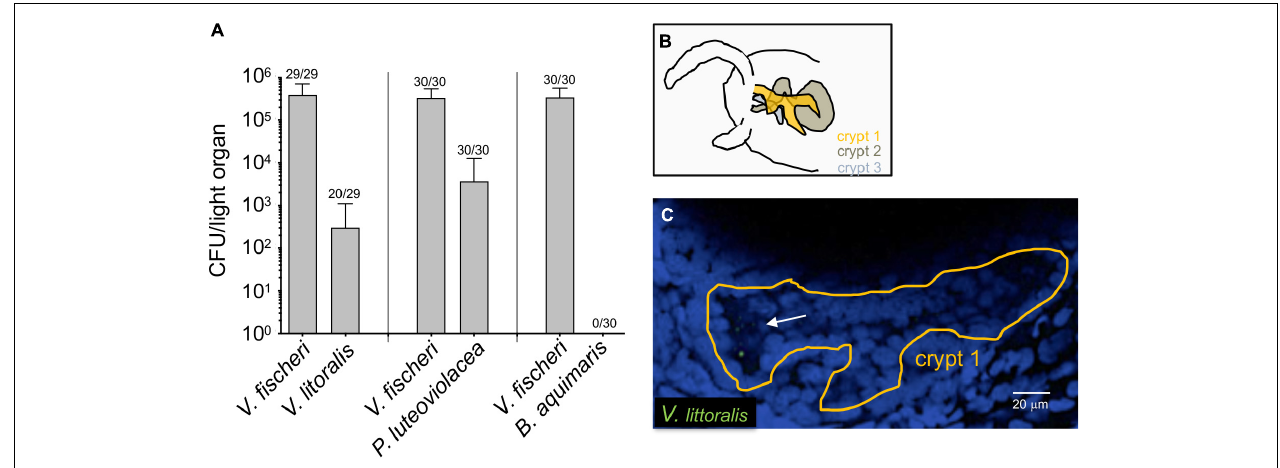
FIGURE 2 | Colonization of newly hatched E. scolopes by environmental bacteria. Juvenile squid were inoculated with pairs of strains consisting of V. fischeri and either V. litoralis ( n = 29), P. luteoviolacea ( n = 30) or B. aquimaris ( n = 30) in three replicates ( n = total number of animals in each condition). (A) The average number of colony-forming units (CFU) present in co-colonized light organs after 24 h. The number above each bar indicates the proportion of animals in which each strain was found; except for the B. aquimaris experiment, in which all the squids were only colonized with ES114; only animals in which both strains were detected were used to calculate the average. (B) Schematic of the interior of one side of a juvenile light organ, indicating the position of the three crypts. (C) One slice of a confocal microscope image of a crypt (tissue nuclei stained blue with TOPRO) in which 8-10 GFP-labeled V. litoralis cells (green) can be seen (arrow). A z-stack movie of the entire crypt can be found in Supplementary Video 1